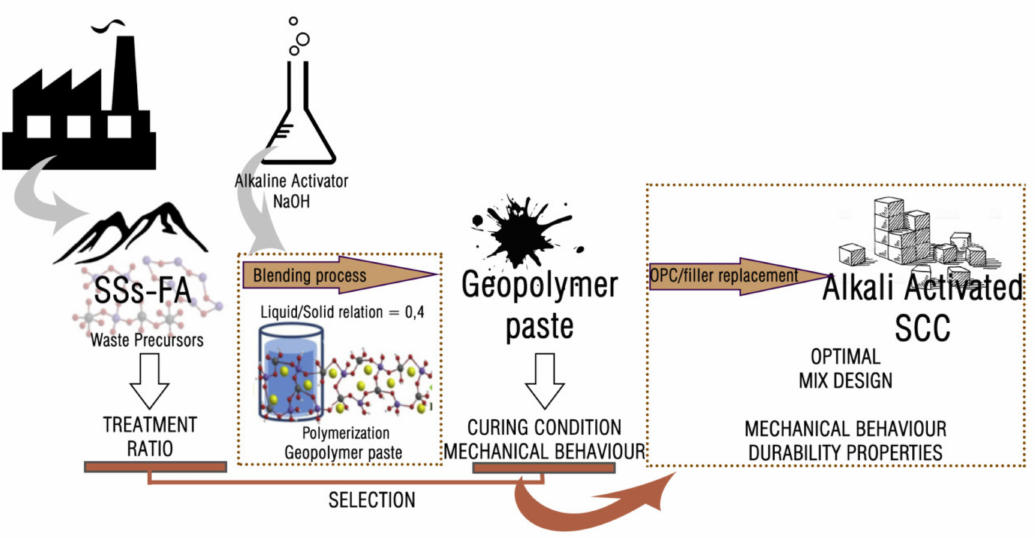
Figure 1. Diagram of the experimental methodology.